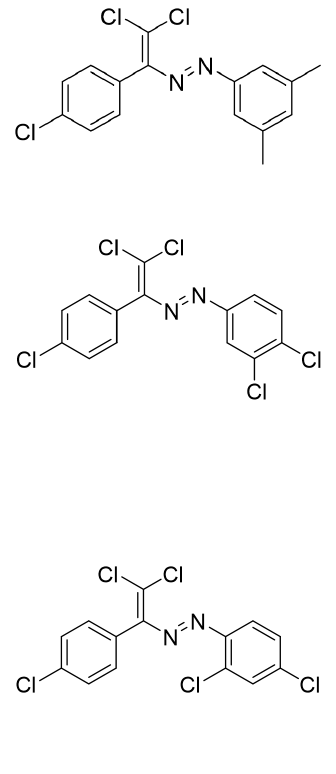
Supplementary Materials: The following are available online . Figure S1. Visualization of electrostatic surface potentials for 10 , 13 – 15 and 17 with selected V s,min /V s,max values (in kcal/mol).Table S1: Crystal data and structure refinement for 10 , 13 - 15 and 17 , Table S2. Values of the density of all electrons— ρ (r), Laplacian of electron density— ∇ 2 ρ (r) and appropriate λ 2 eigenvalues (with promolecular approximation), energy density—H b , potential energy density—V(r), and Lagrangian kinetic energy—G(r) (a.u.) at the bond critical points (3, –1), corresponding to Cl···F halogen-halogen contacts in 13 , Table S3. Cartesian atomic coordinates for model supramolecular associates.